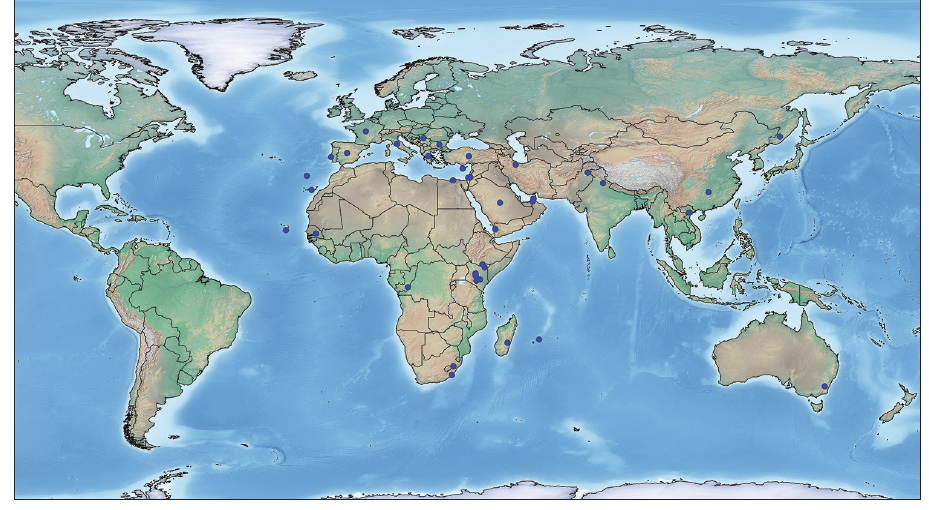
Figure 1. Worldwide distribution of Apanteles hemara